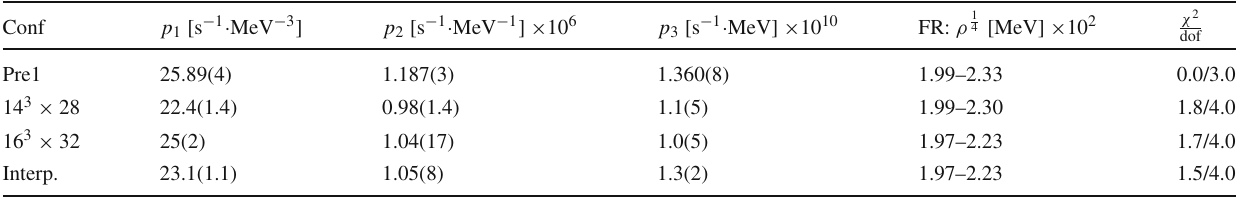
Table 28 The fitting results of the lifetime τ by the curve τ = prediction τ